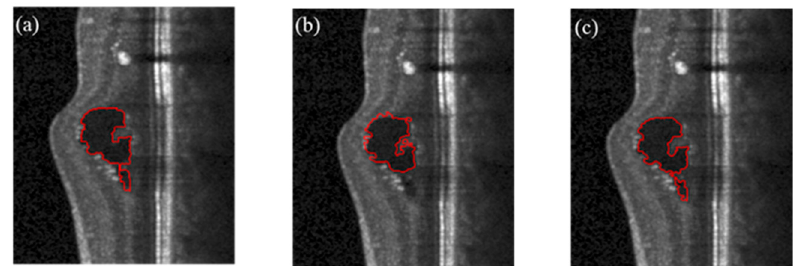
Figure 7. Segmentation results of the operator in different directions, ( a ) the result of 4-direction operator; ( b ) the result of 6-direction operator; ( c ) the result of 8-direction operator. Table 2. Comparison of the operator with a different number of directions. Dice Index Precision Recall F1-Score 4 directions 0.811 0.888 0.750